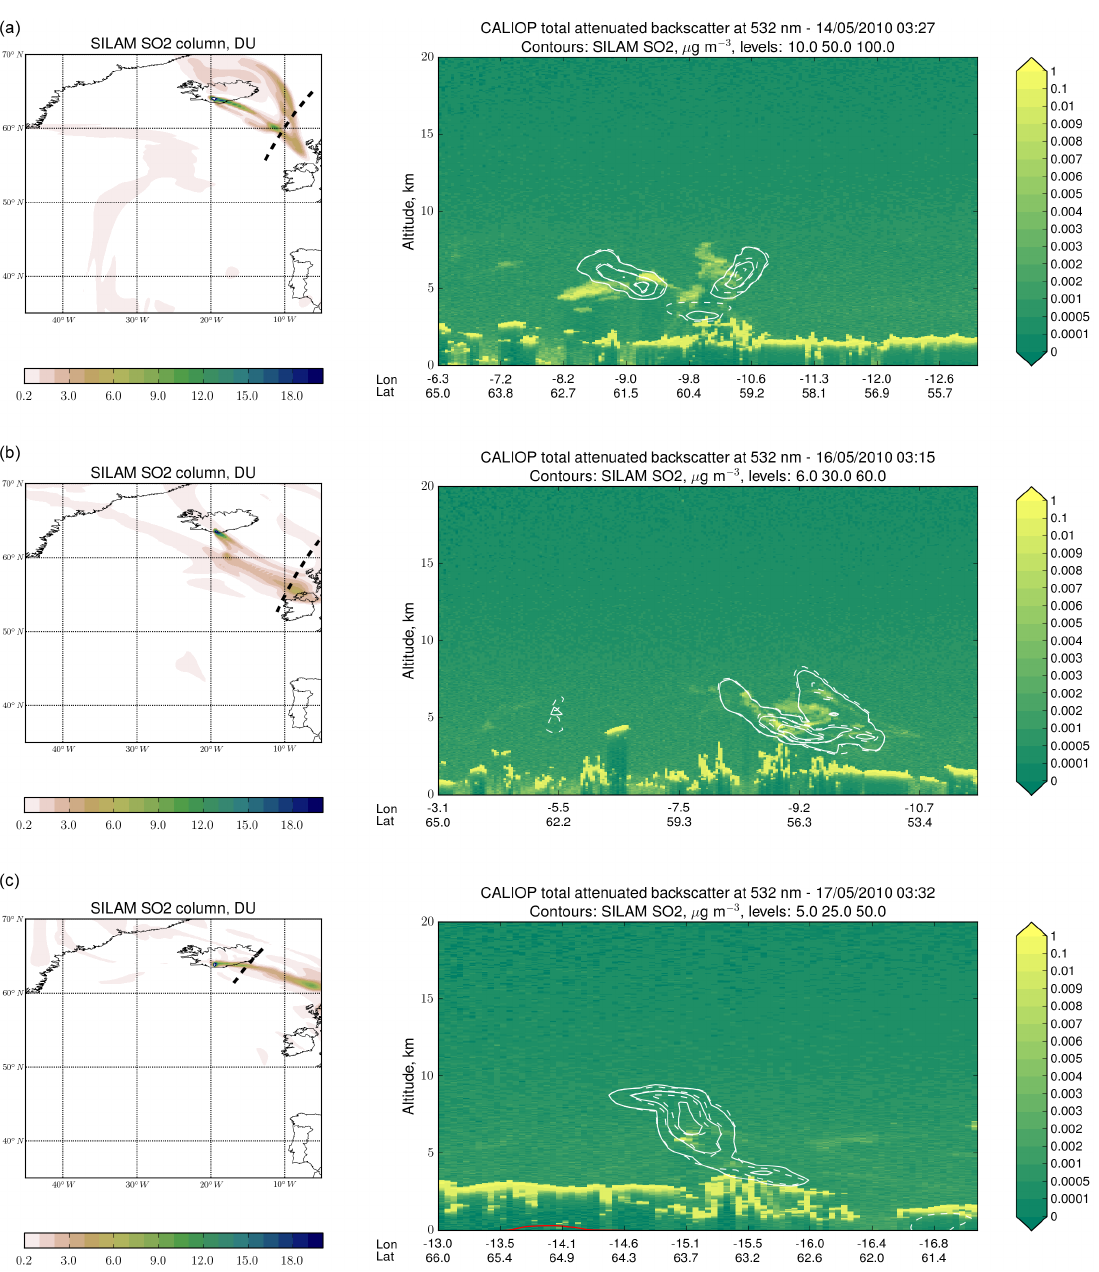
Figure A1. Comparison of simulated SO 2 concentration compared to CALIOP total backscatter at 532nm on 14 (a) , 16 (b) and 17 (c) May 2010. The inversion with only total column retrievals is shown in dashed contours. The contour levels (µgm − 3 ) are 10, 50 and 100 in (a) , 6, 30 and 60 in (b) and 5, 25 and 50 in (c)